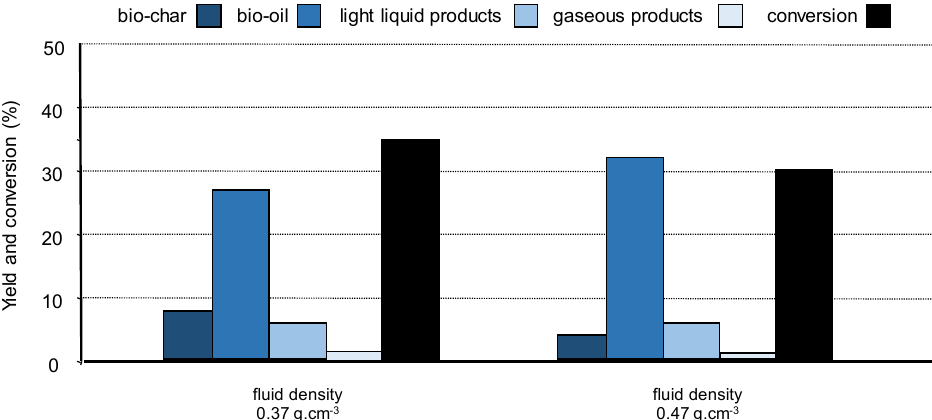
Figure 9. Pine wood conversion in supercritical ethanol at 250 °C. Influence of the fluid density on